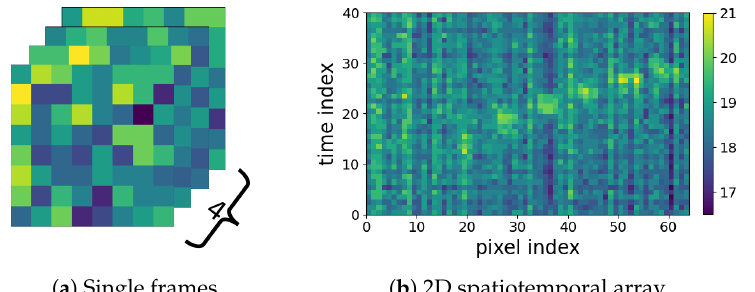
Figure 1. ( a ) Examples of 8 × 8 pixel frames for the walking diagonally activity, and ( b ) the vectorized spatiotemporal 2D array over 40 frames and 64